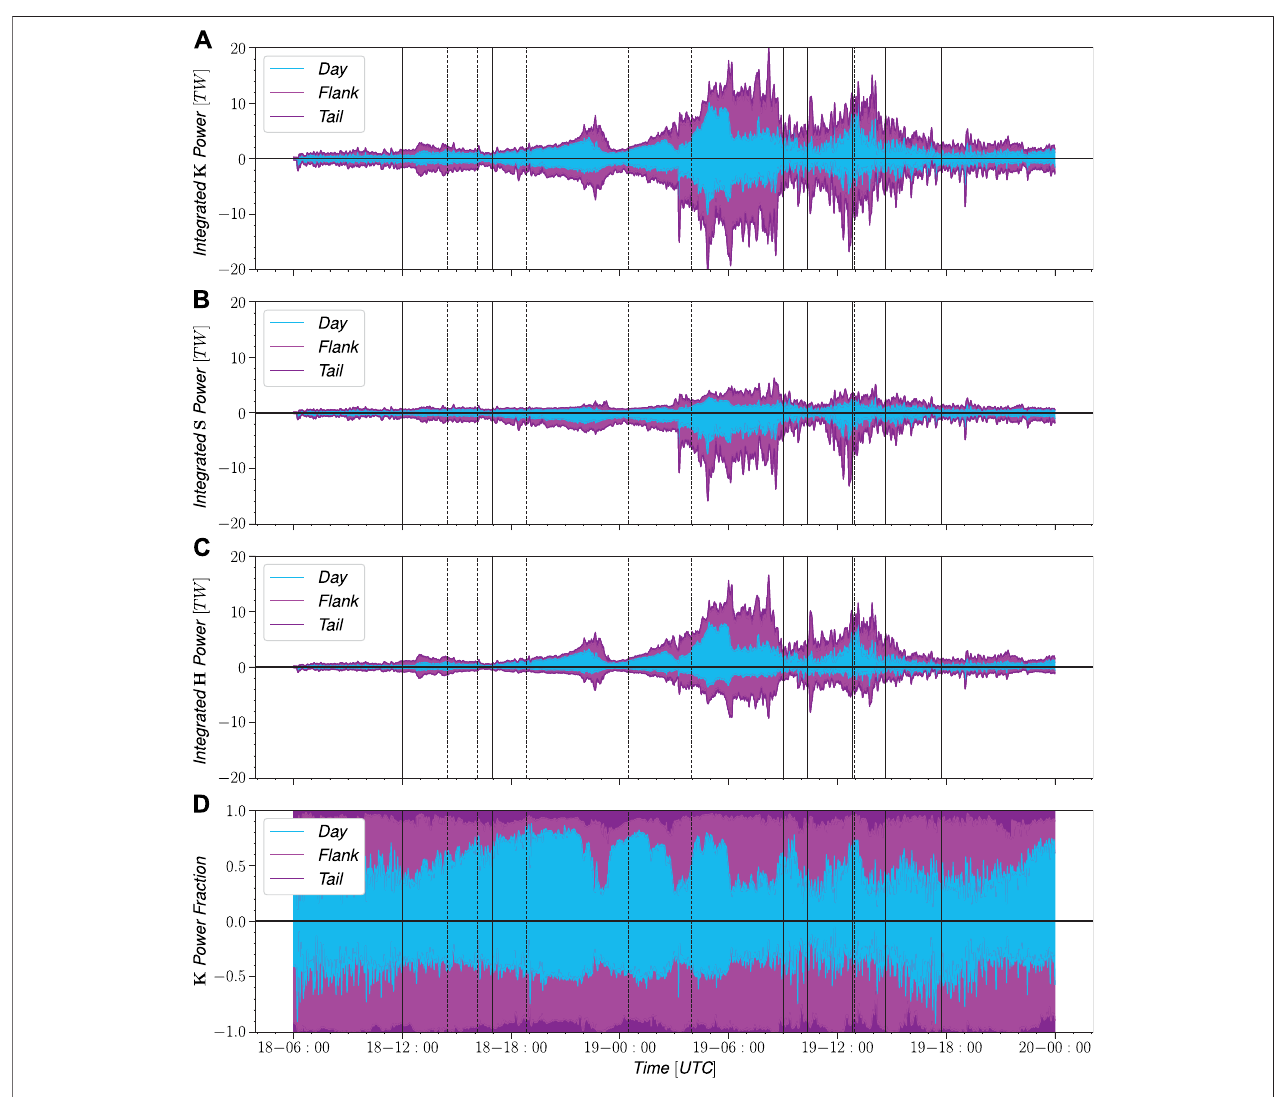
FIGURE11| Energy injection and escapestacked bycontribution. The fi rst stackrepresentscontributionfrom the dayside startingfrom 0. Next isthecontribution fromthe fl ankstartingfromthedaysidecontributionandlastlyisthecontributionfromthetailcaptotallingtotheinjectionandescapevaluesfoundin Figure9 .Asbefore the (A) represents total energy transfer, the (B) is Poynting fl ux and the (C) is the hydrodynamic energy fl ux. The (D) shows the relative